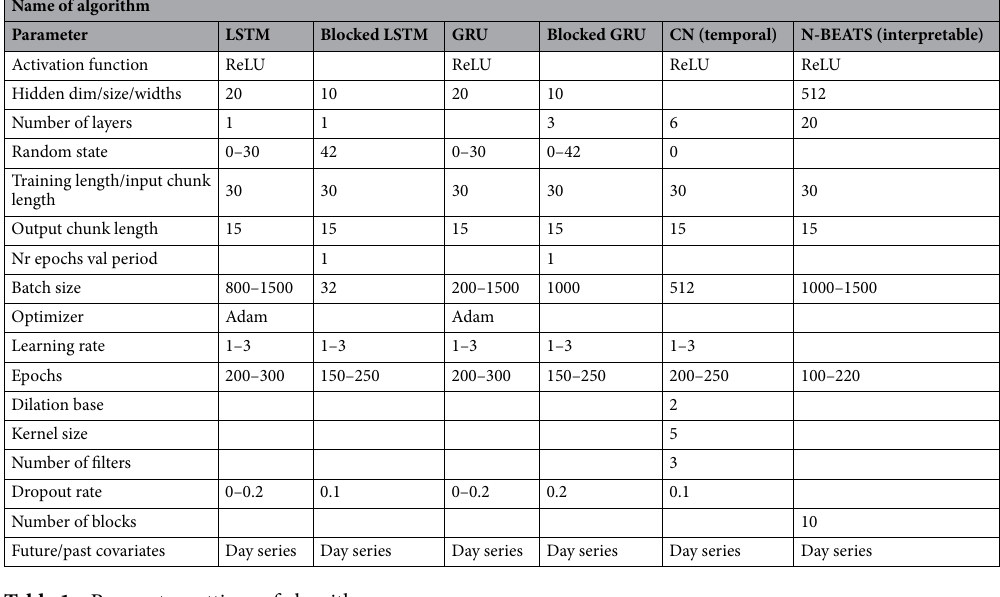
Table 1. Parameter settings of